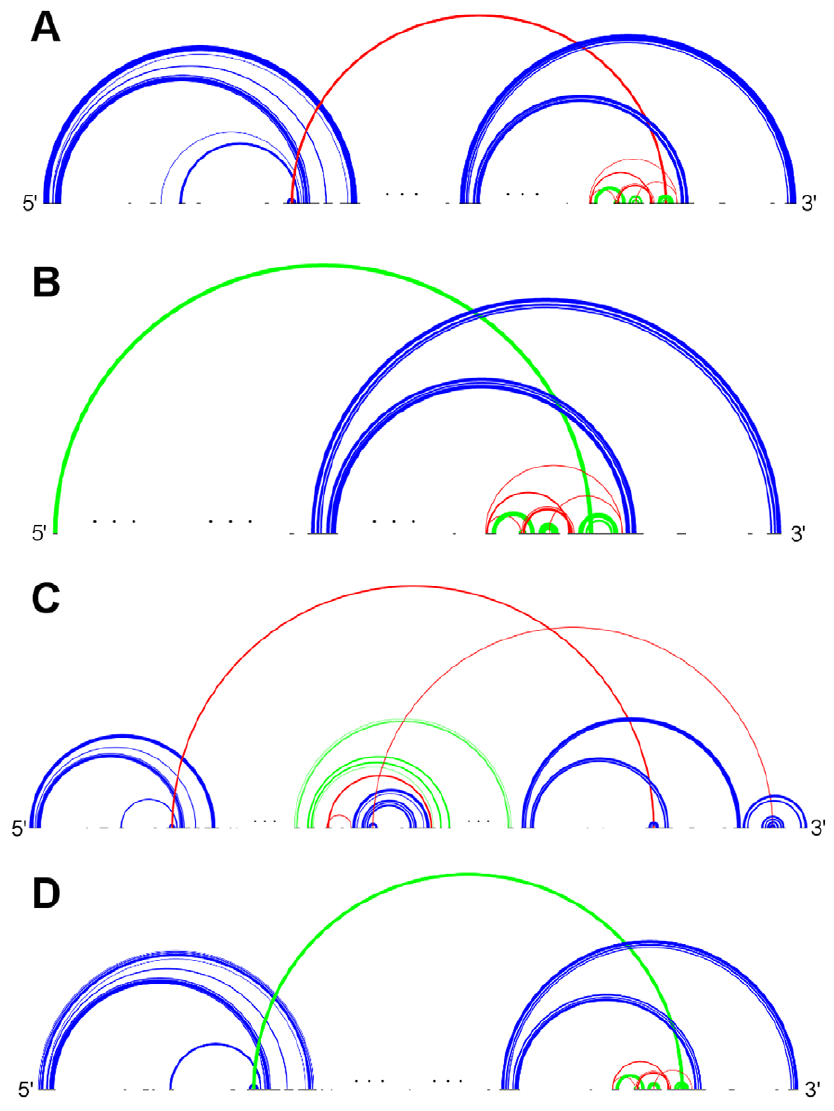
Figure 5. Typical sample structures for all genus 3 subclasses . A: RNA sequence CRW_00490 of subclass 3A with pseudoknot pattern ABACDEFGEHGIJIFHKBKDJC. B: RNA sequence CRW_00527 of subclass 3B with pseudoknot pattern ABCDEFDGFHIHEGJAJCIB. C: RNA sequence PDB_00628 of subclass 3C with pseudoknot pattern ABACDEDFGFECHBHIGI. D: RNA sequence CRW_00525 of subclass 3D with pseudoknot pattern ABACDEFDGFHIHEGJBJIC. (Stem color, blue: major stem; green: intermediate stem; red: minor stem).